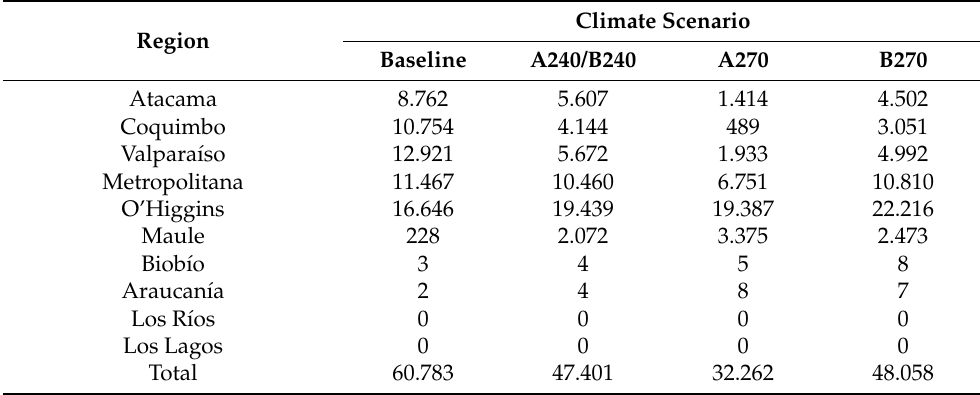
Table 5. Land area under table grapes by region and climate-change scenario (hectares). Climate Scenario Region Baseline